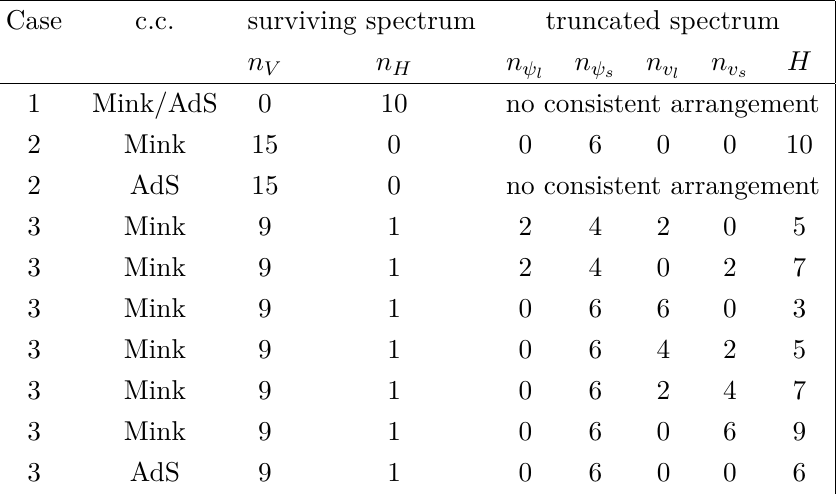
Table 3 . Supersymmetry breaking patterns and truncation of the spectrum — cases